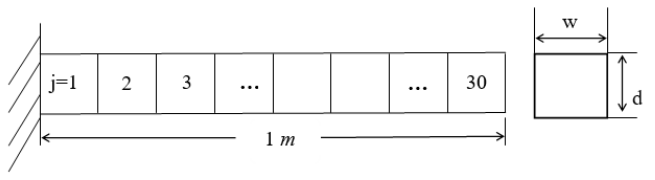
Figure 11. The Euler–Bernoulli cantilever beam model.